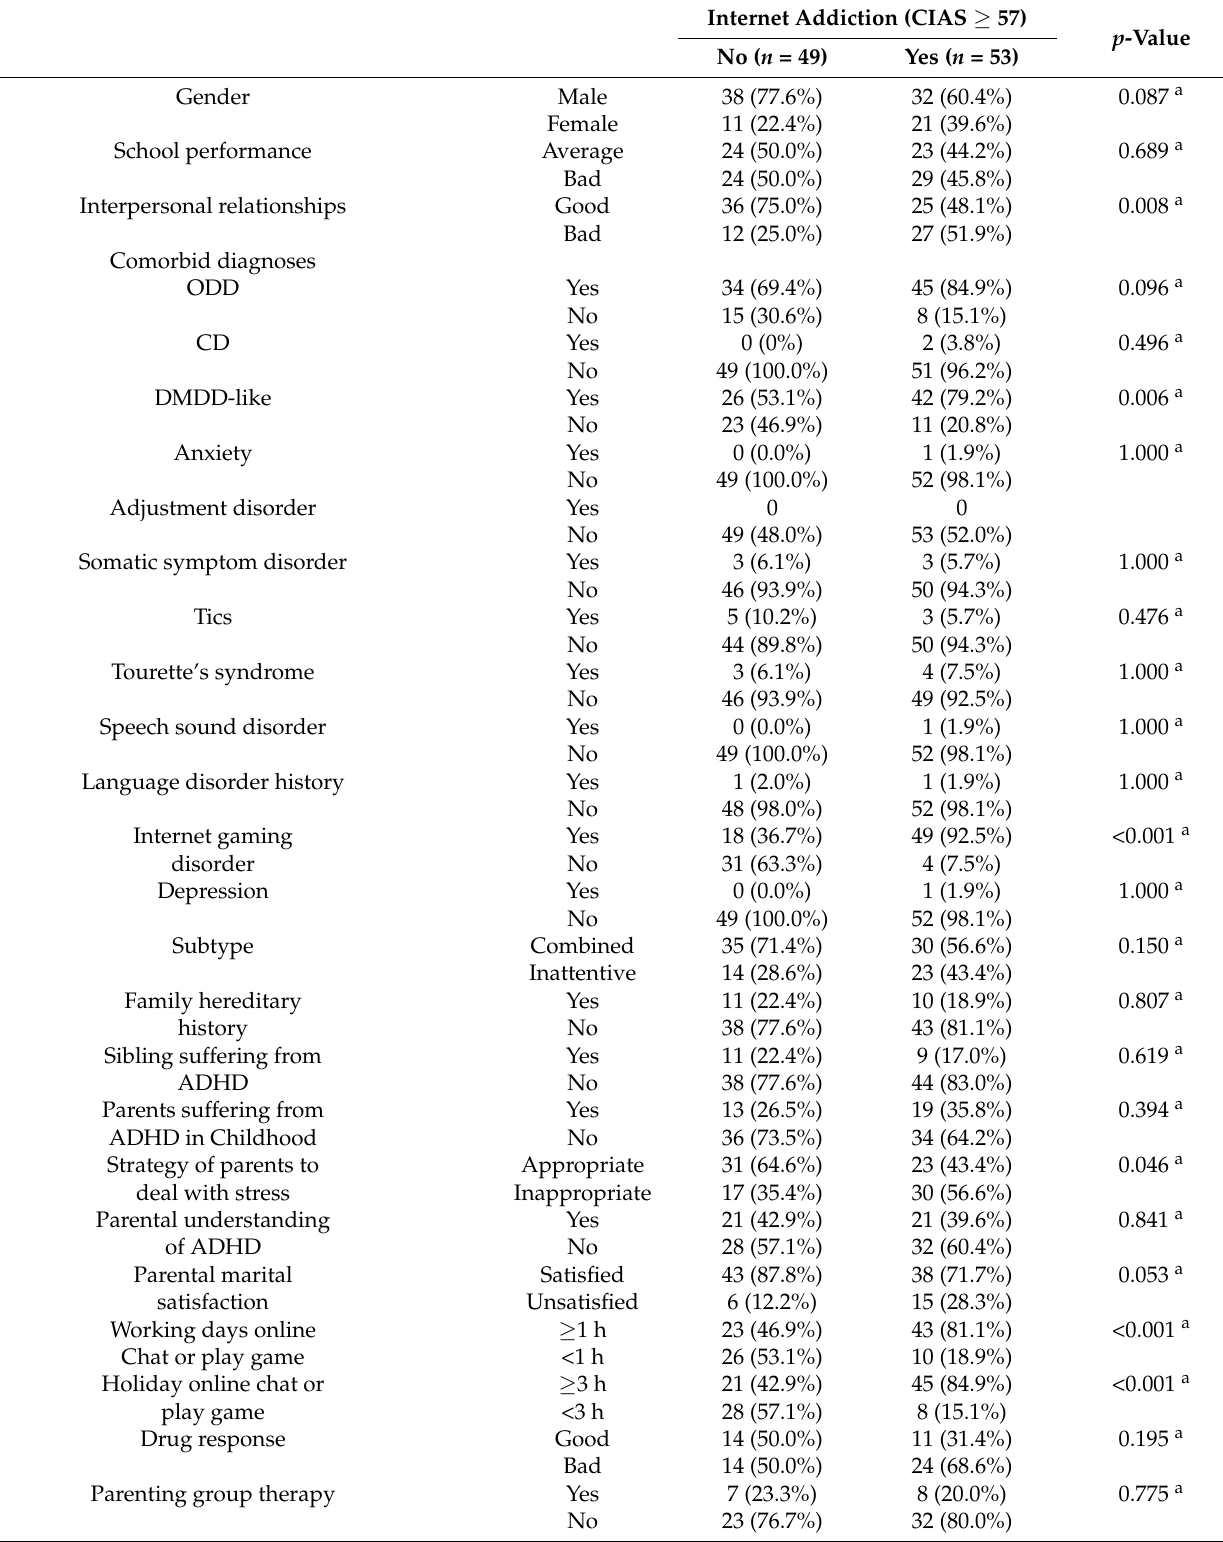
Table 1. Comparisons of the baseline characteristics of the children with ADHD between IGD and non-IGD